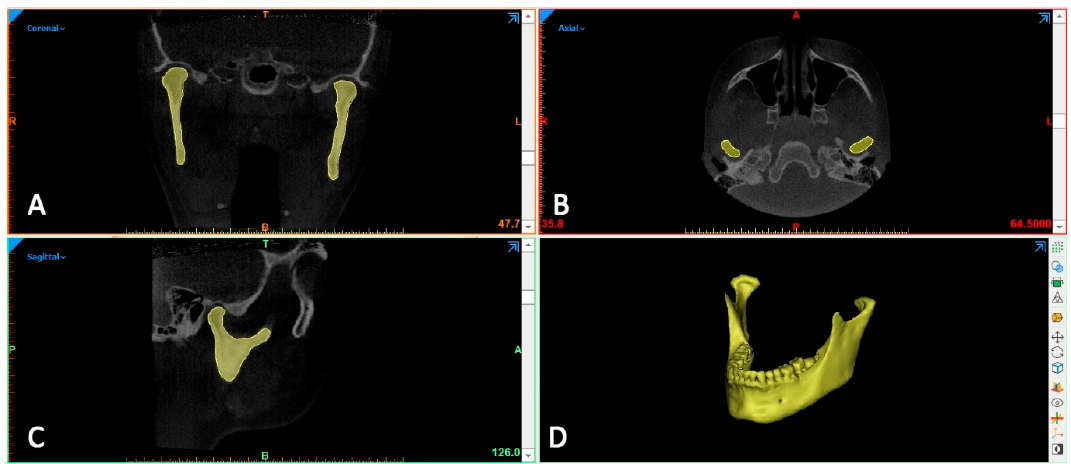
Figure 1. Manual segmentation of mandibular jaw (ground truth); (A) coronal view; (B) axial view; (C) sagittal view; (D) 3D rendered mandible model.